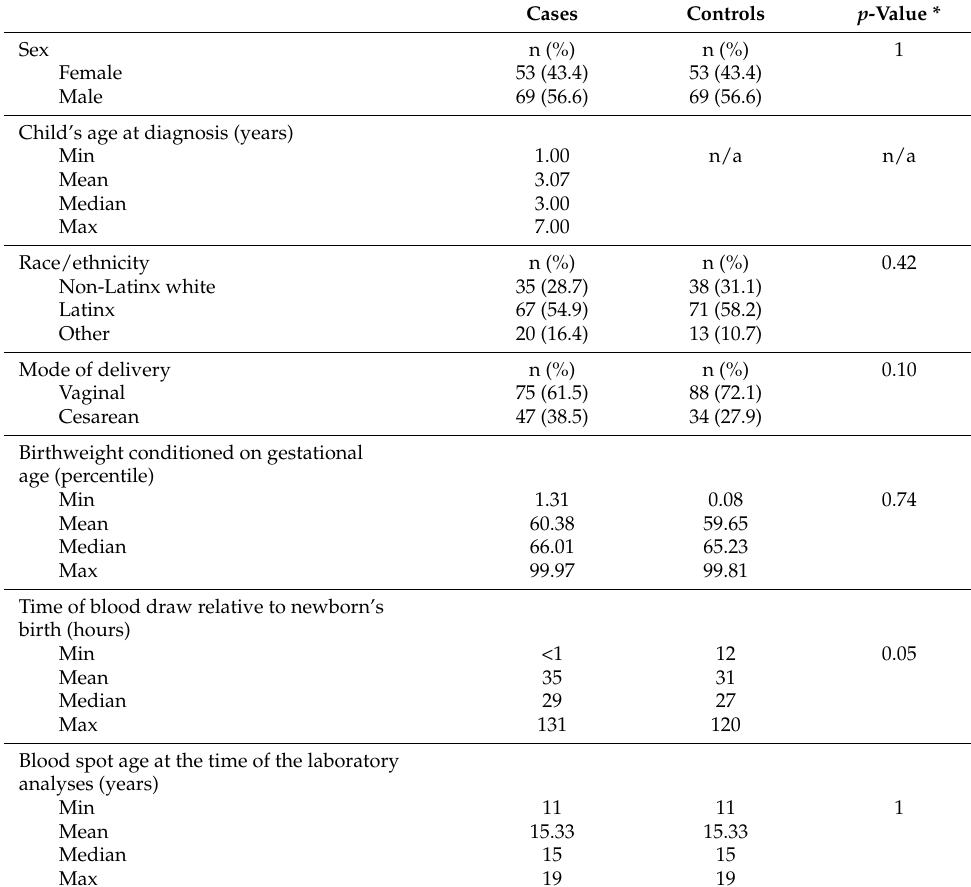
Table 1. Demographic summary statistics by case/control